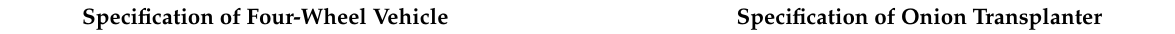
Table 1. Specification of the 12-kilowatt self-propelled riding-type automatic onion transplanter under